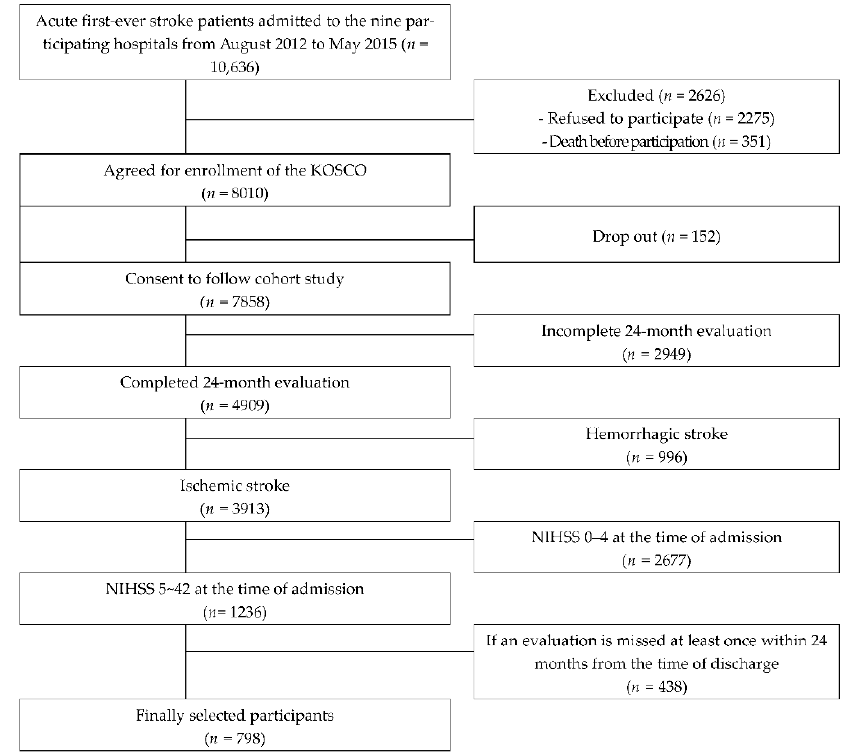
Figure 1. Flow diagram of the study participants.